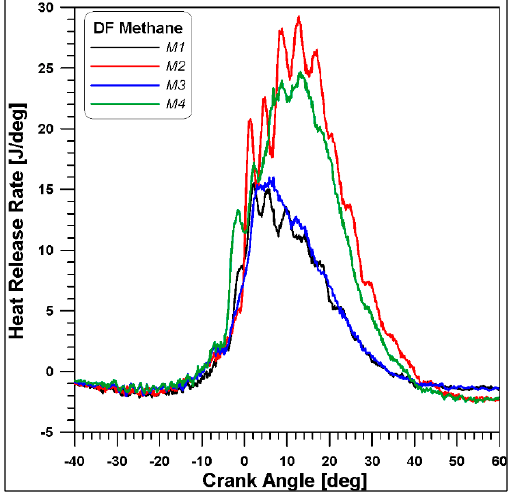
Figure 3. Experimental heat release rate. Cases with methane.